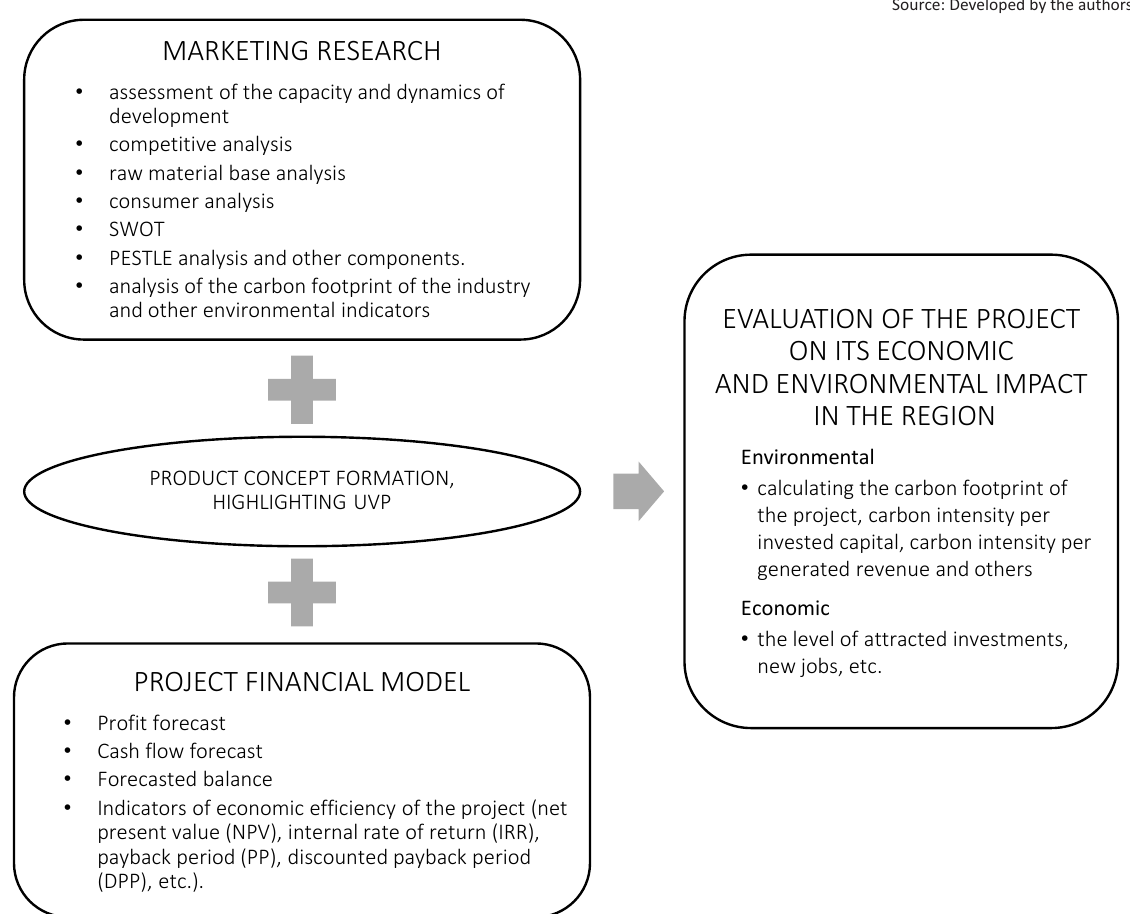
Figure 1. Key stages in preparing of an investment model using environmental indicators